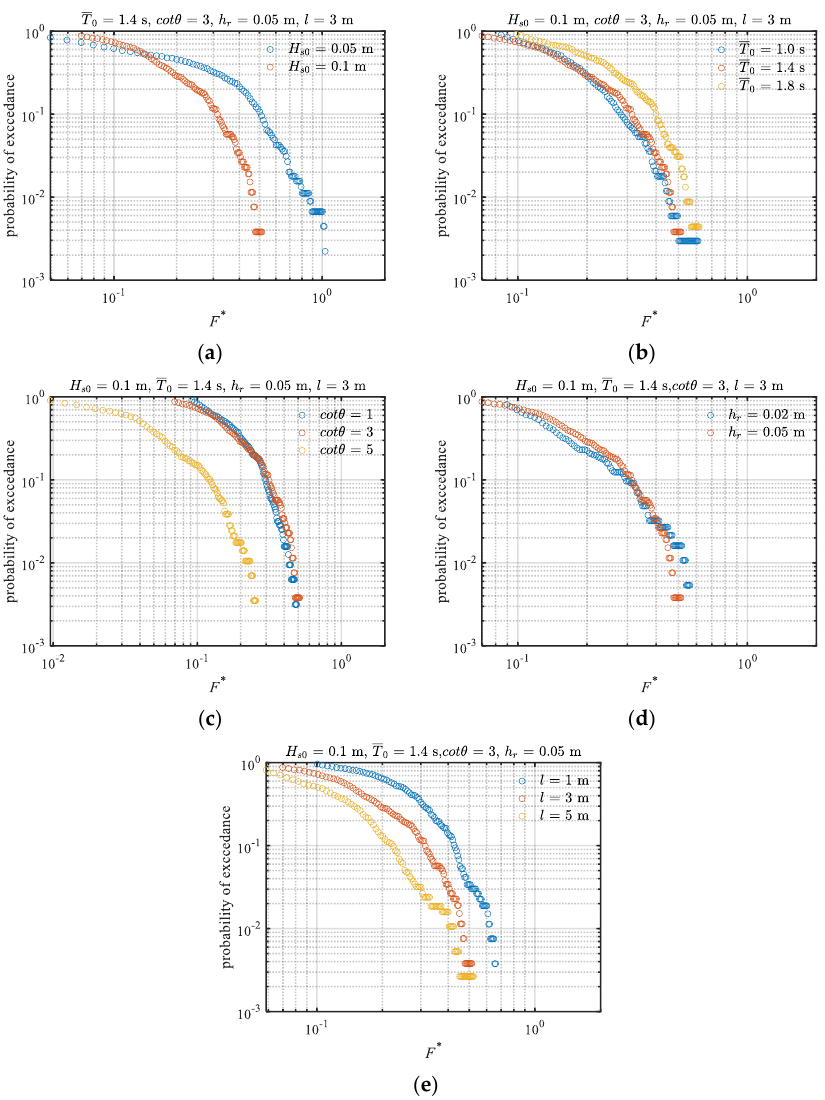
Figure 27. Probability of exceedance of irregular wave forces on the sloped seawall for different cases: ( a ) H s 0 ; ( b